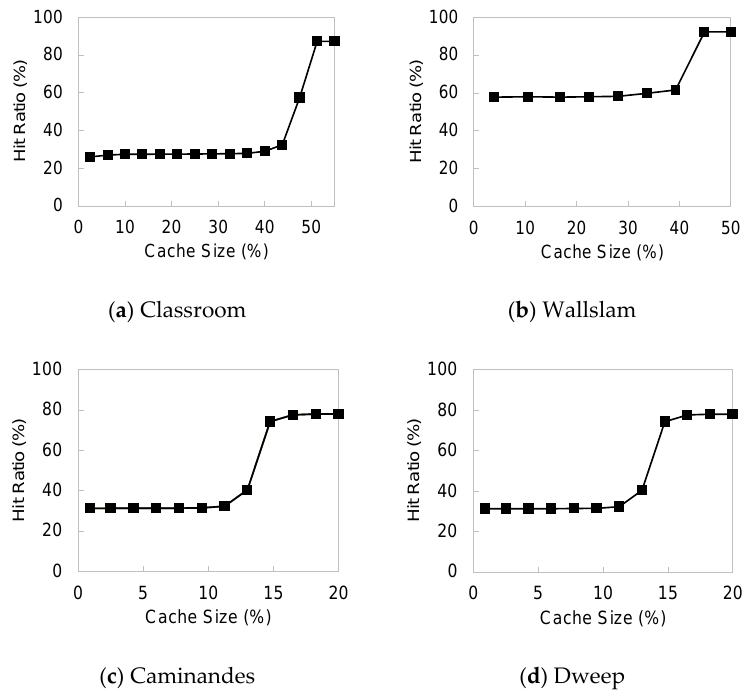
Figure 2. Buffer cache performance in rendering systems.